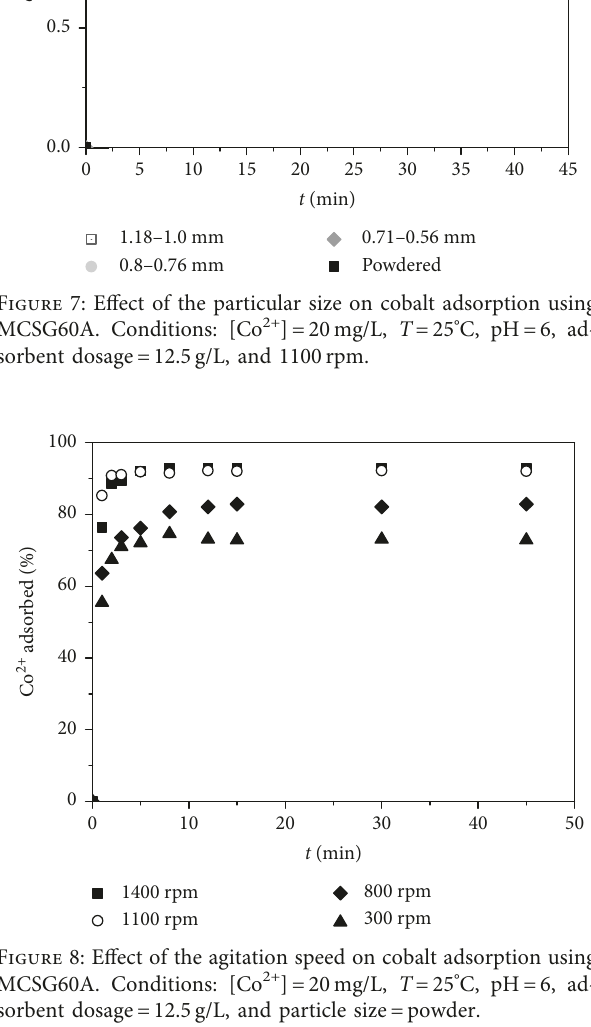
12.5 g/L, and particle size (cid:30)